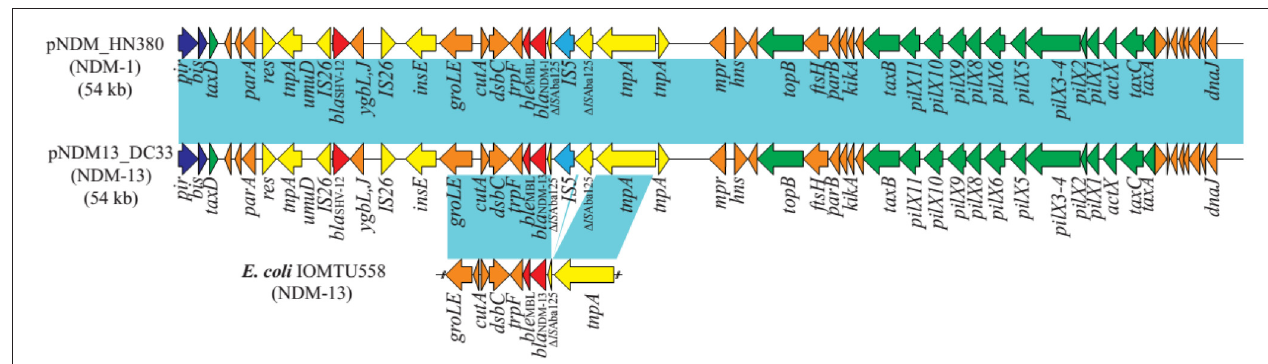
FIGURE 2 | Plasmid structures of pNDM_HN380 (JX104760), pNDM13_DC33(KX094555) and the bla NDM - 13 neighboring genetic environment in IOMTU558 (LC012596). Colored arrows represent open reading frames, with dark blue, yellow, green, red, light blue, and orange arrows representing replication genes, mobile elements, plasmid transfer genes, resistancegenes, IS 5 , and plasmid backbone genes, respectively. Blue shading denotes regions of shared homology among different plasmids.